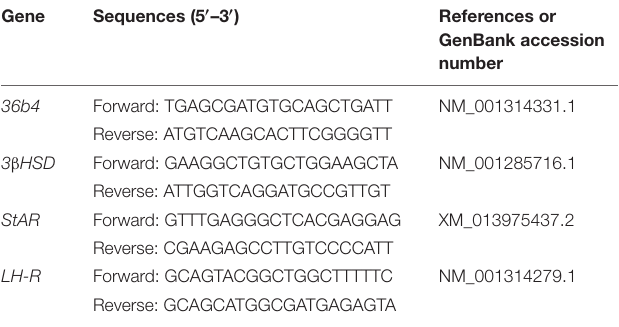
TABLE 2 | Primer sequences used for Real time quantitative